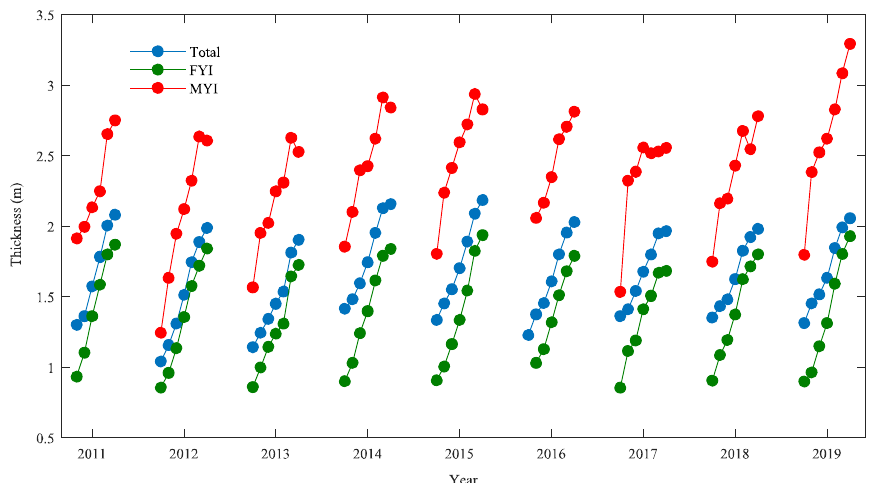
Figure 6. Monthly average thickness variations of the Arctic sea ice from November 2010 to April 2019 estimated using the LSA method. The blue dots indicate total ice thickness, the green dots indicate first-year ice thickness, and the red dots indicate multiyear ice thickness.